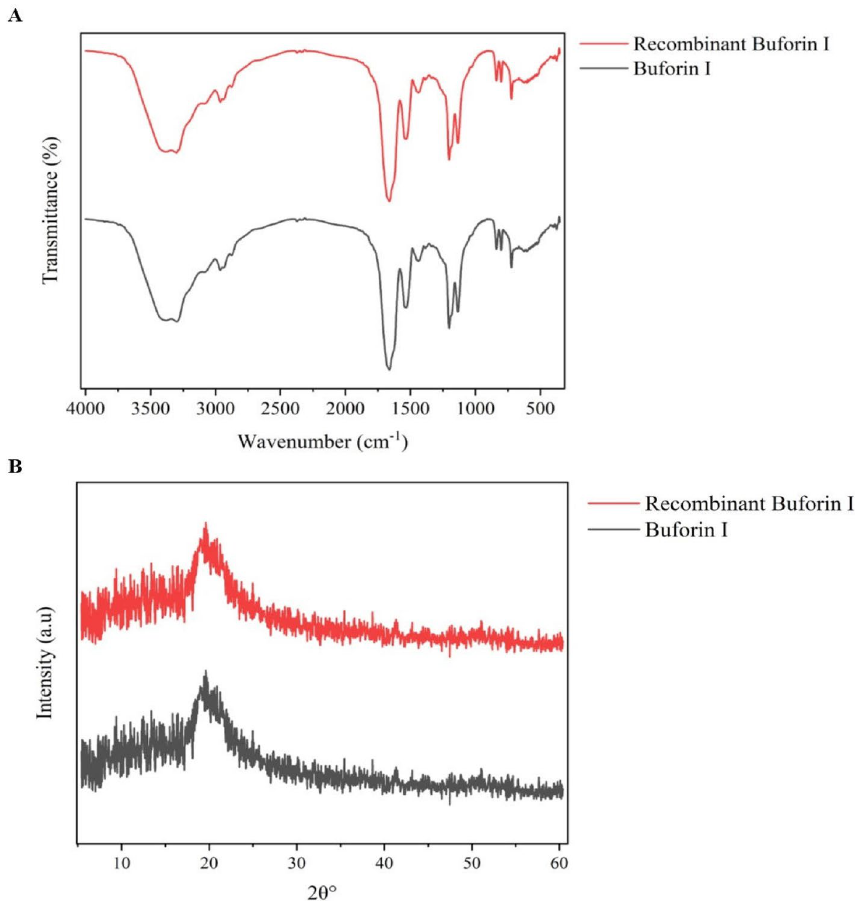
Figure 10. In vitro assessment of stability of buforin I and recombinant buforin I. ( A ) FTIR, ( B )